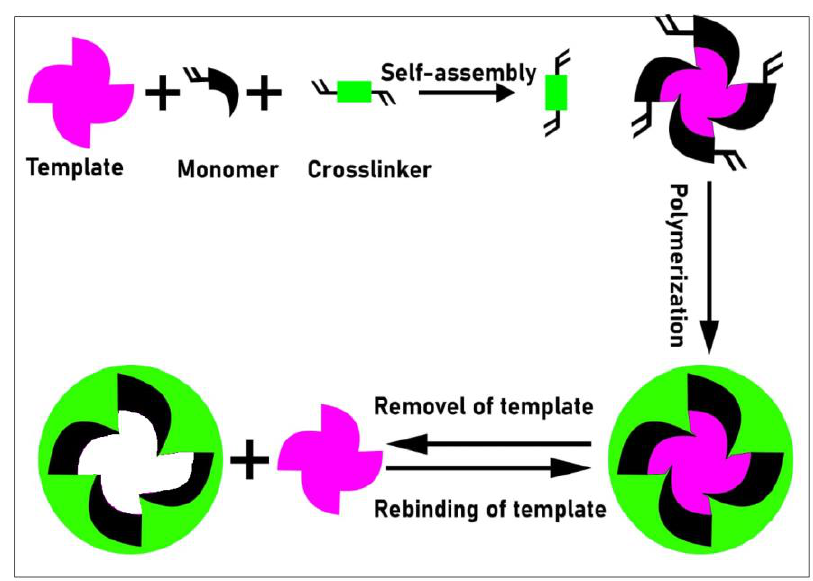
Figure 1. Adsorptive mechanism scheme of AB-234 dye on an MIP.